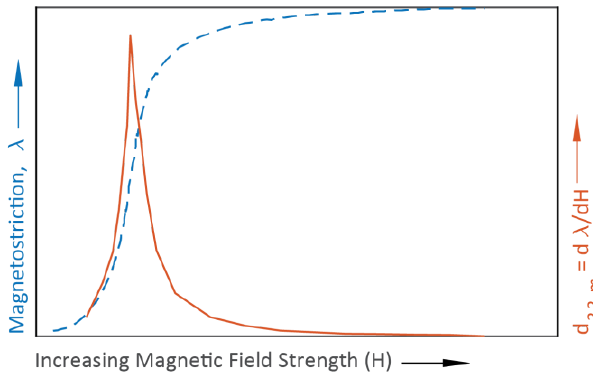
Figure 4. A typical magnetostriction profile and its derivative. Adapted from [25].